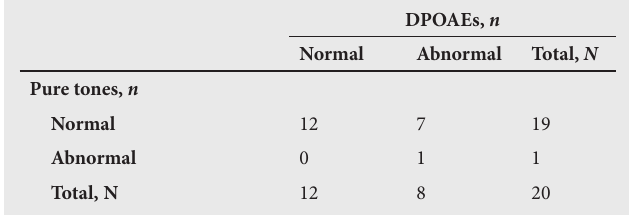
Table 4. Cross classification of pure tone thresholds and DPOAEs for stage 3 participants for 6 000 Hz/5 000 Hz